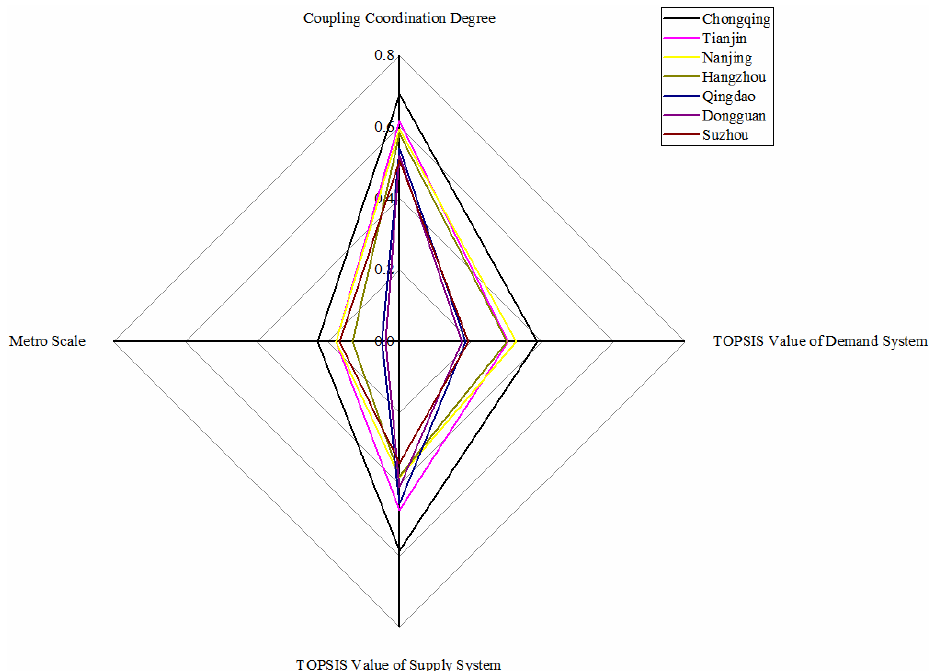
Figure 5. Metros in barely balanced with lagging demand